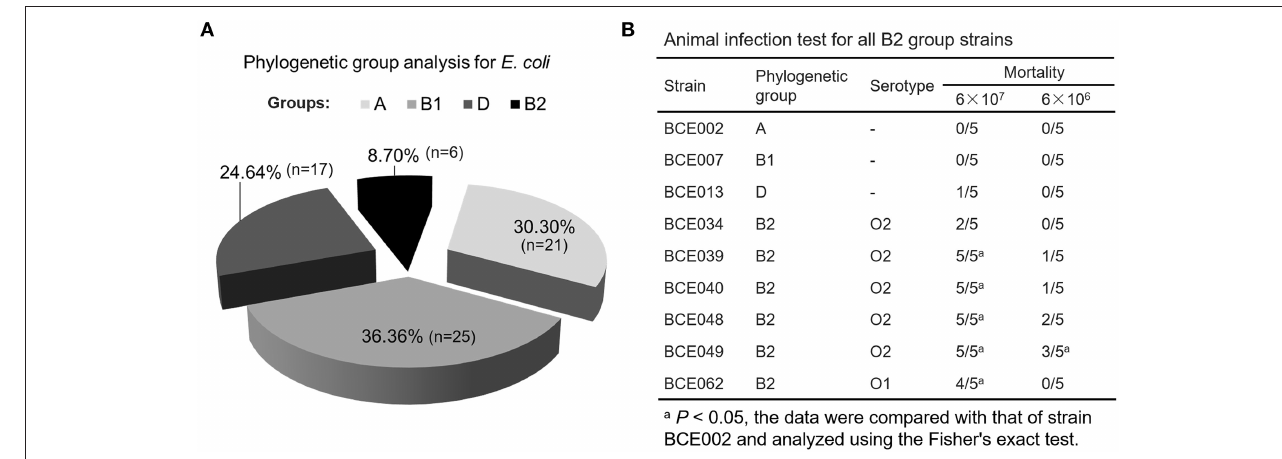
FIGURE 2 | The pathogenicity of phylogenetic group B2 E. coli isolated from the bovine mastitis. (A) The proportion of E. coli isolates belonging to different phylogenetic groups. (B) Animal infection test for all B2 group strains.